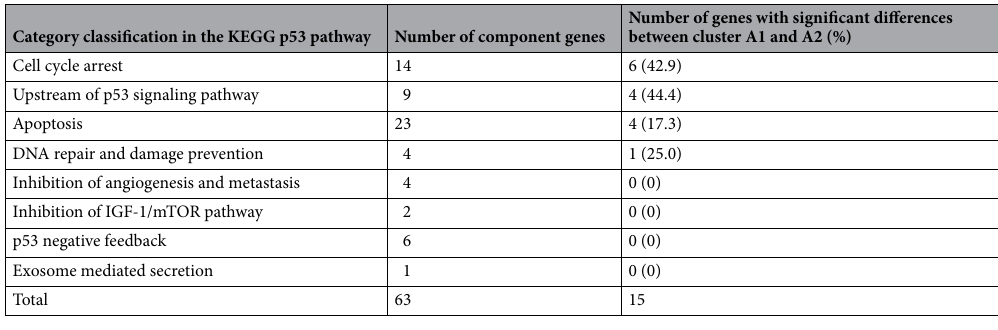
Table 2. Results of comparison of gene expression between cluster A1 and A2 (counted for each category classification).